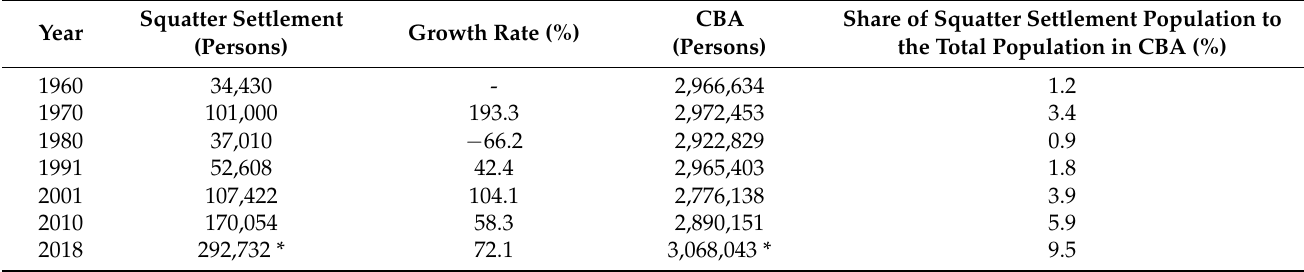
Meanwhile, the policies implemented during the 1990s aggravated almost all socio- economic indices, such as income disparity, real incomes, unemployment, and underem- ployment [48]. During this period, the squatter settlement population increased by more than 104%, having a significant inflow of international migration from bordering